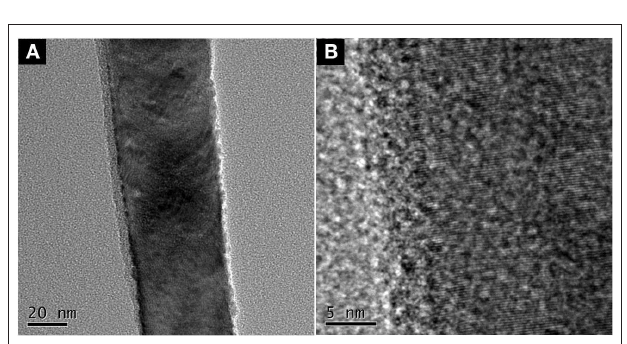
FIGURE 6 | (A) TEM image of and (B) HRTEM.